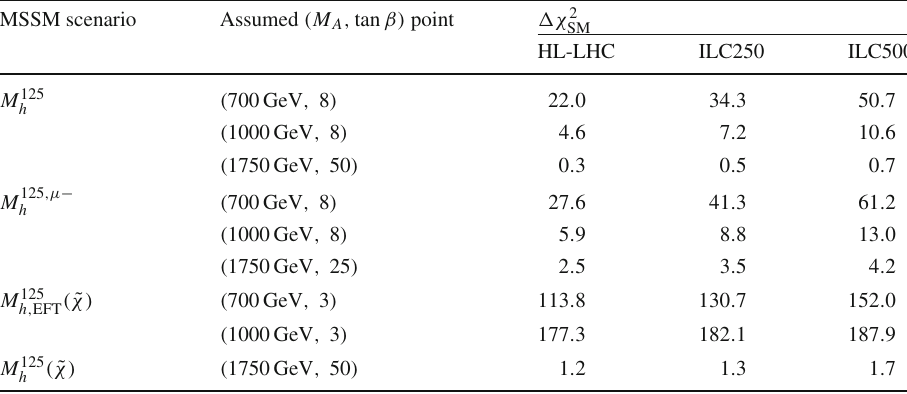
Table 1 Goodness-of-fit of the MSSM scenario Assumed ( M A , tan β) SM hypothesis, (cid:5)χ 2 , from a SM test against future signal rate measurements of the Higgs boson at 125GeV at the HL-LHC and in combination with ILC250 and ILC500 measurements, assuming different MSSM realizations in nature